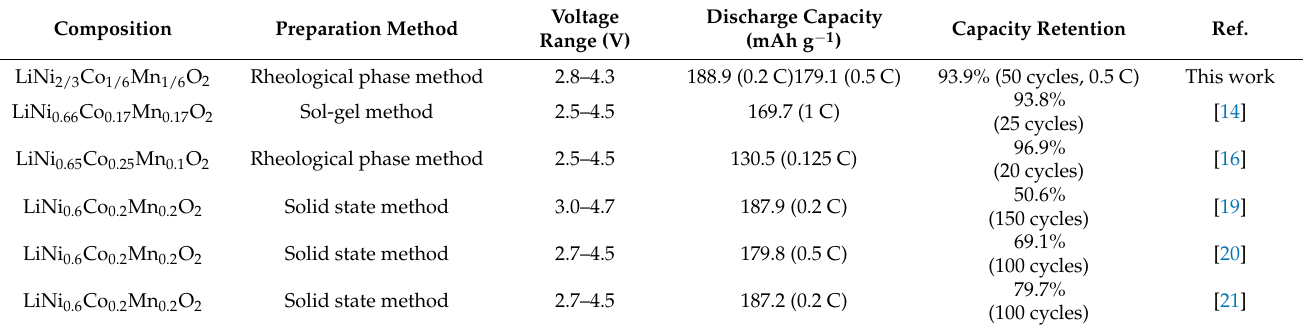
Table 3. Comparison of electrochemical performance of LiNi 1-x-y Co x Mn y O 2 (0.6 ≤ Ni content < 0.7) materials from different